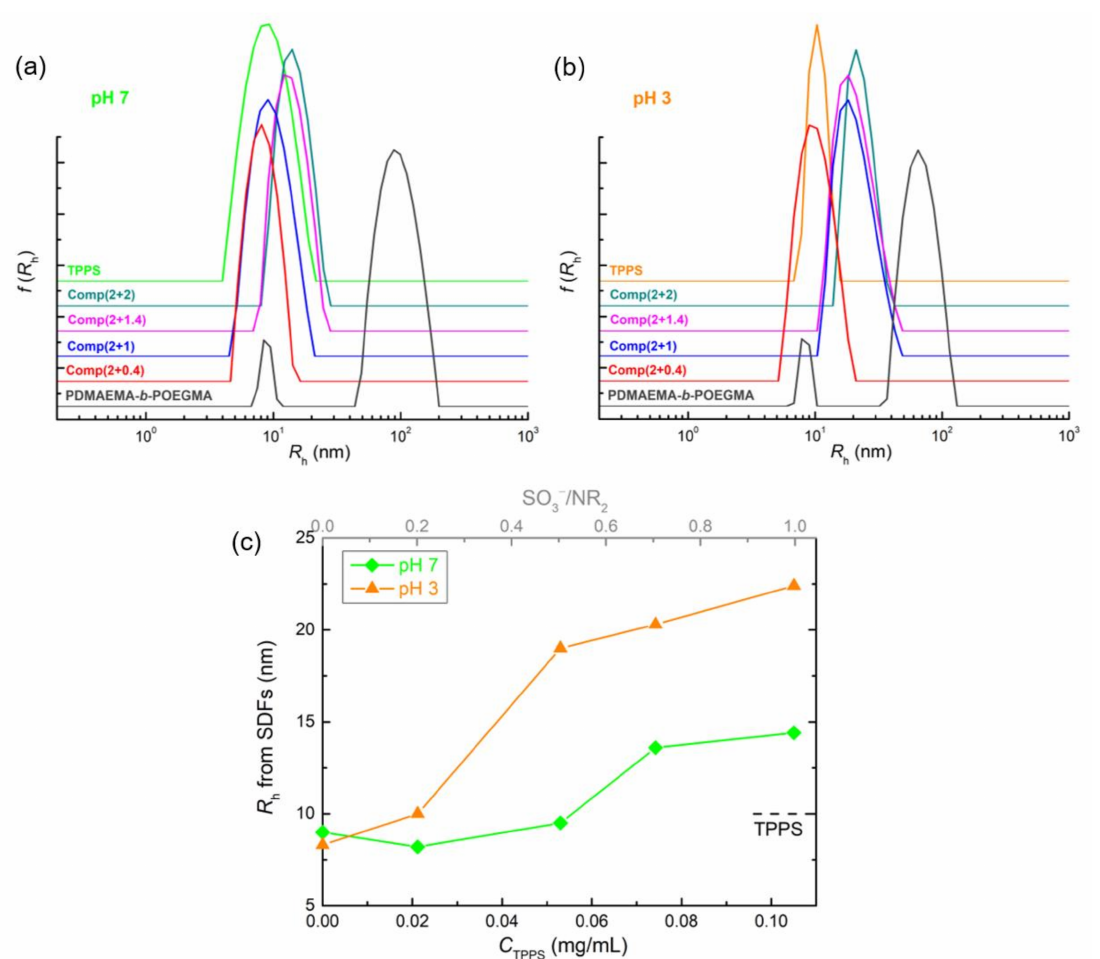
Figure 2. Size distribution functions (SDFs) derived from DLS measurements at 90 ◦ for the DHBC/TPPS complex solutions at pH ( a ) 7 and ( b ) 3, along with ( c ) the R h values of the indi- vidual peaks as a function of C TPPS or SO 3 − /NR 2 ratio. The dashed line denotes the corresponding R h value of neat